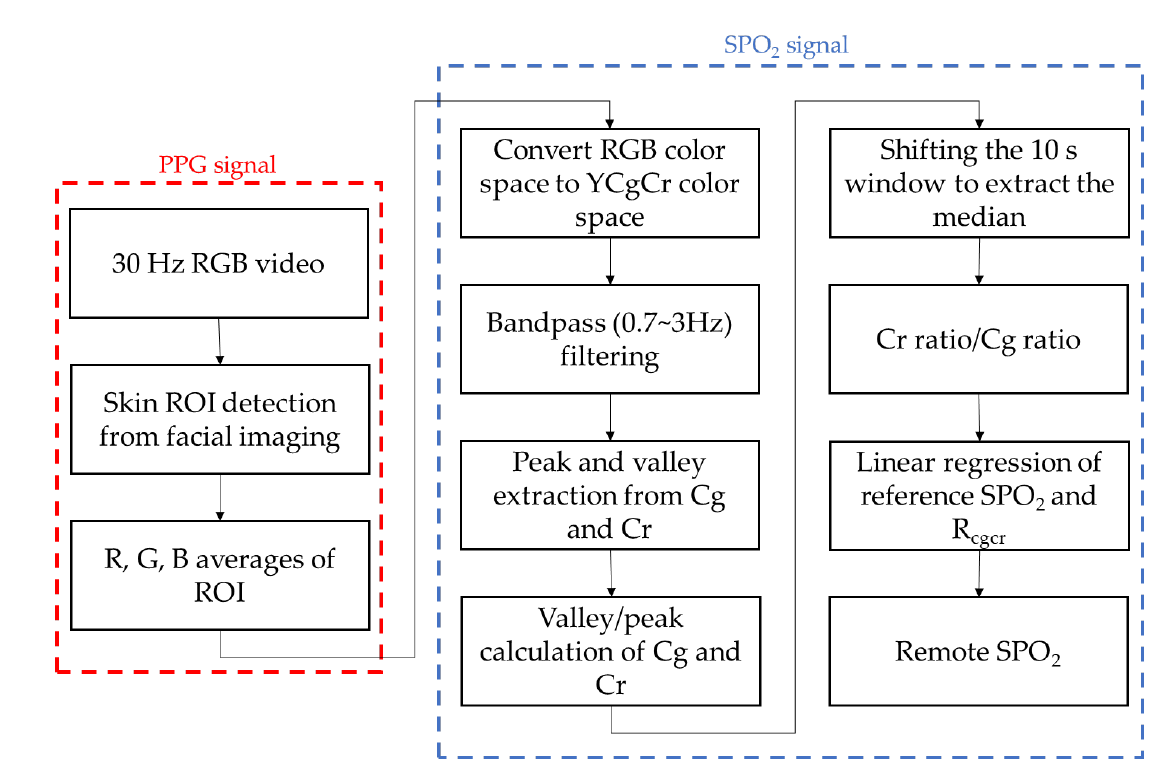
Figure 2. Non-contact oxygen saturation measurement process. R = red; B = blue; G = green; ROI = region of interest; R cgcr = Cr ratio/Cg ratio.